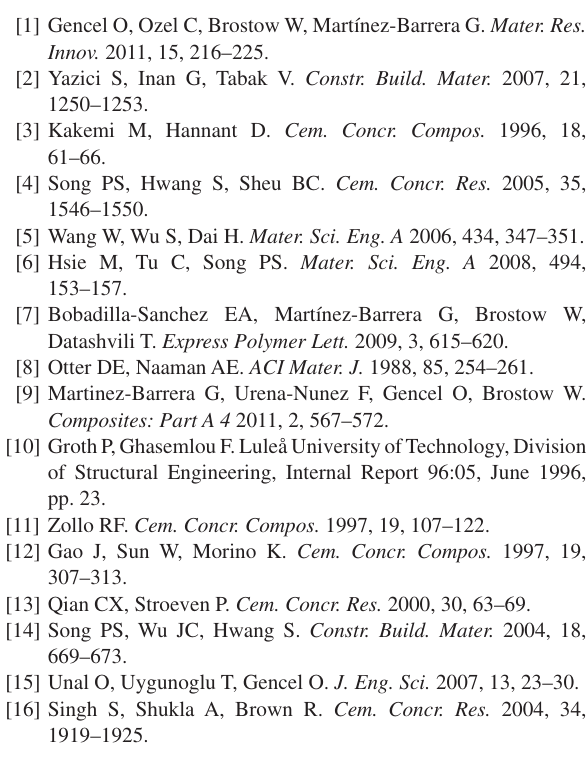
Figure 9 Elasticity modulus of